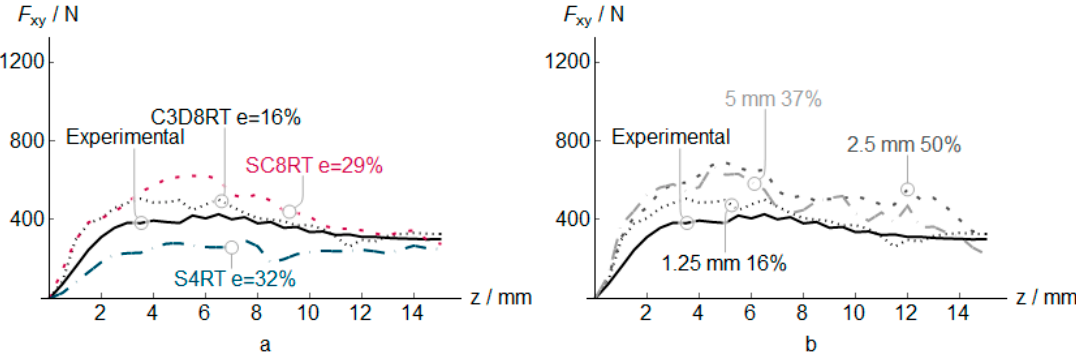
Figure 4. Vertical force F z in PVC incremental forming. Experimental vs. predicted mean values at z positions, and estimation error e for different elements ( a ), and different C3D8RT sizes ( b ).